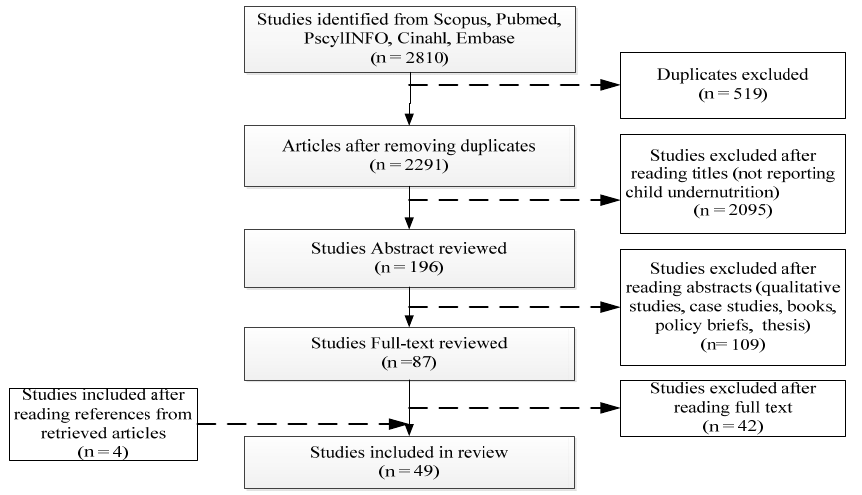
Figure 1. Flow chart for study selection based on PRISMA 2015 guidelines.